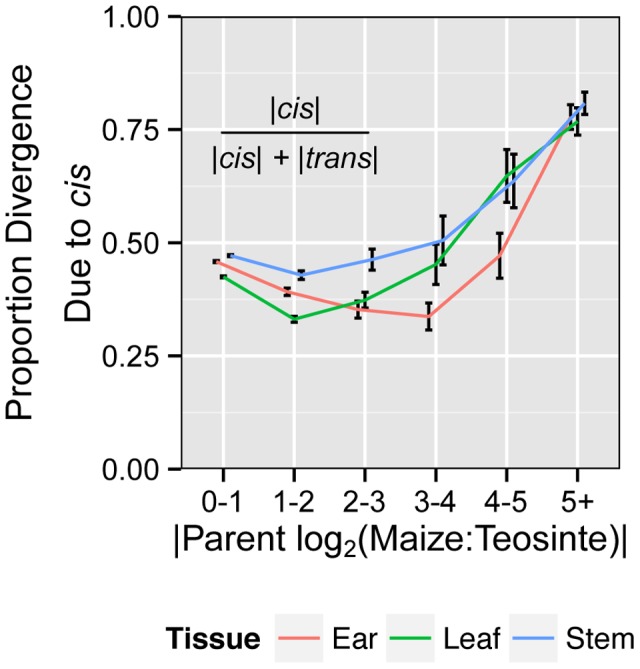
Proportion of expression divergence due to cis regulatory differences.The amount of total differential expression between the maize and teosinte parents due to the directly measured cis effect (F1 hybrid expression ratio) is shown with error bars depicting 95% confidence intervals. Total divergence (log2 of parent expression ratio) was binned from 0–1, 1–2, 2–3, 3–4, 4–5, and 5+. Divergence due to cis effects increases with total divergence, suggesting large expression differences tend to be caused by cis rather than trans regulatory differences.